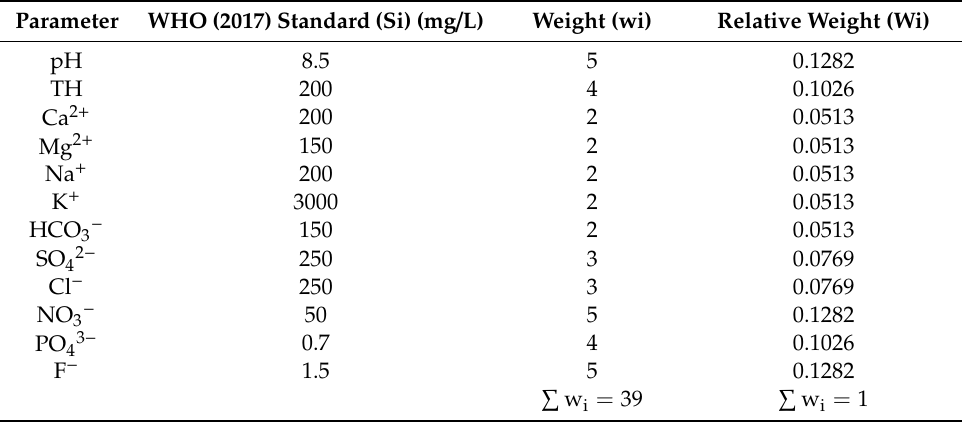
Table 5. Standards, weights and relative weights used for WQI computation.